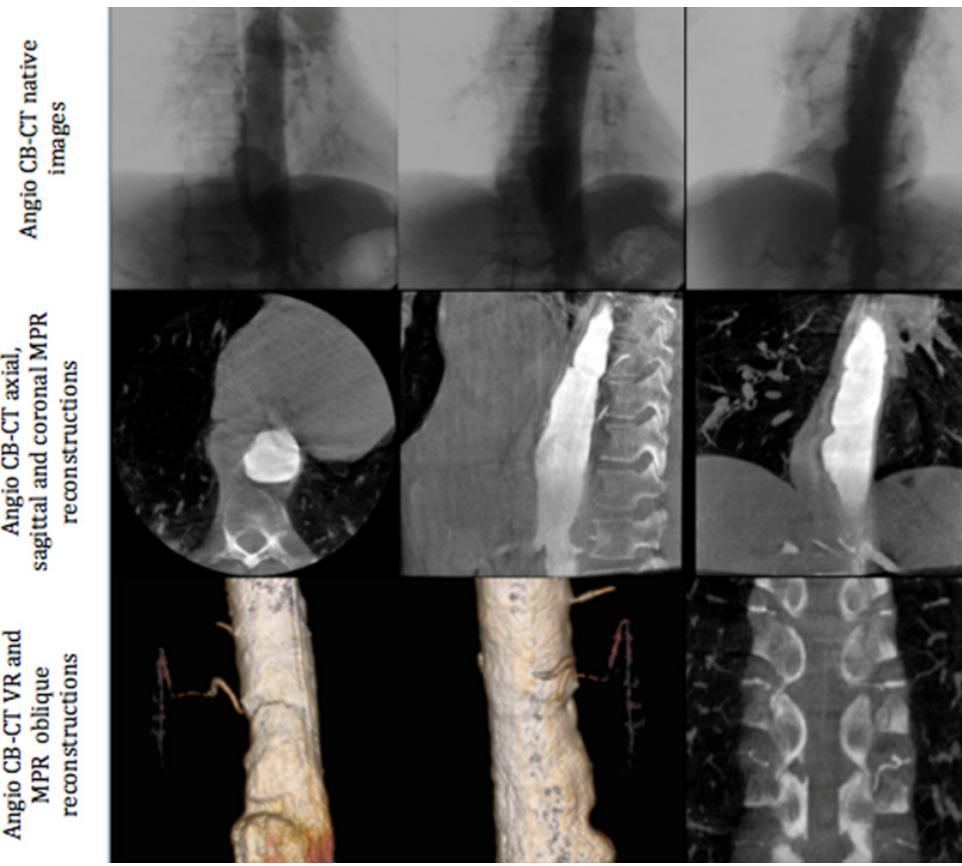
Figure 1. Different phases of angio-CBCT image acquisition: native images (upper section), MPR reconstructions (middle section), and volume rendering and oblique reconstructions (lower section).